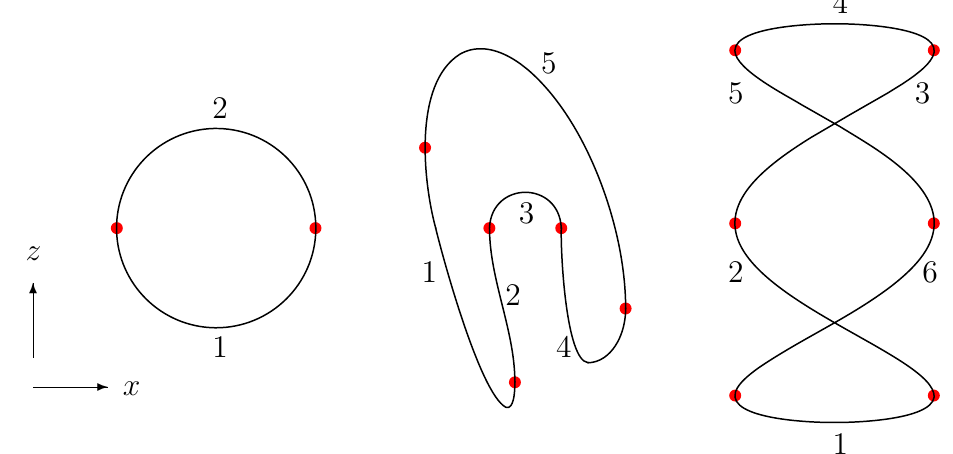
Fig. 4 Three examples of closed curves, partitioned into N segments (numbered n = 1 ,..., N ) at the points (indicated in red) where the curves become vertical ( x (cid:10) = 0), meaning the corresponding tangent geodesic has one endpoint at infinity. Through (11), the sign of x (cid:10) on each segment determines whether the tangent geodesics have their end- points in the canonical order ( x − < x + ) or not. The circle has already